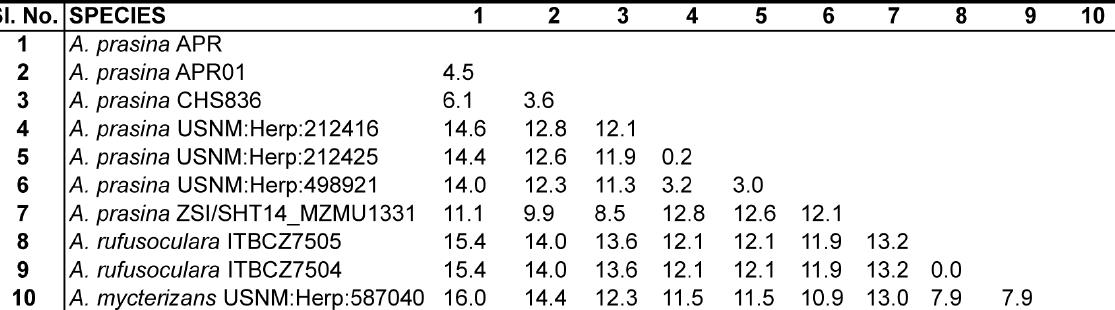
Table 5d. Interspecific genetic distance ( p- distance) estimated from COI